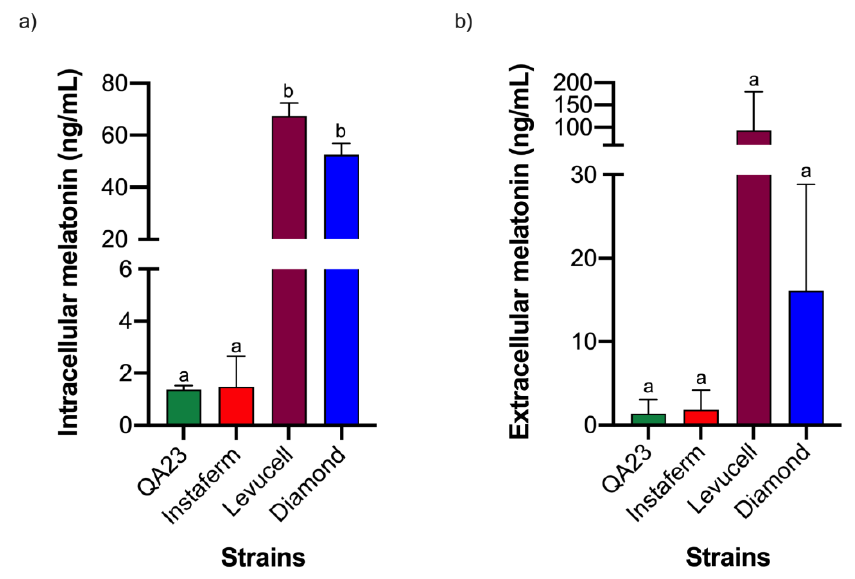
Figure 3. Maximal intracellular ( a ) and extracellular ( b ) melatonin concentration by di ff erent Saccharomyces strains. Intracellular melatonin is expressed in ng / mL per 10 OD. Error bars represent ± SD of n = 3 by ANOVA. Di ff erent letters indicate significant di ff erences between strains. p < 0.05.